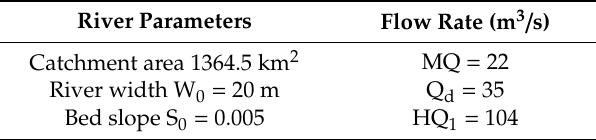
MQ = mean flow; Q d = design flow; HQ 1 = 1-year flood.